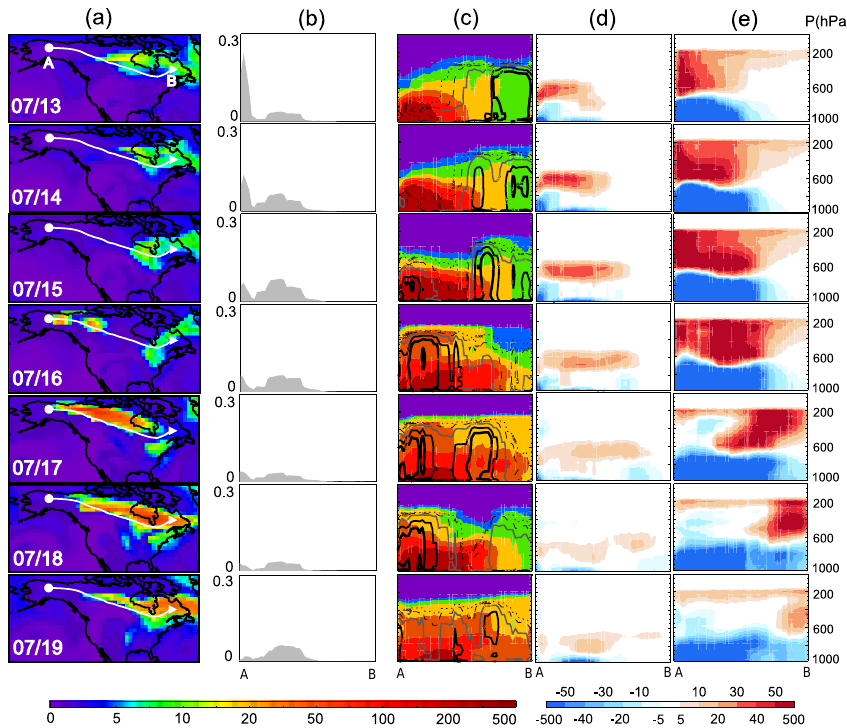
Fig. 14. Simulated daily mean CObbNA (CO from North American biomass burning source) during 13–19 July 2004. (a) CobbNA (ppbv) at 300hPa from the synoptic simulation. White line A–B is derived from the back trajectory analysis using the HYSPLIT model. The starting point B [55 ◦ N, 67 ◦ W] is located at 5km above the ground level and the back trajectory starting time is 00:00UTC, 19 July . (b) Total biomass burning emission rate (TgC/month) in grid cells along the trajectory A–B. (c) CObbNA vertical profile along the trajectory A–B from the synoptic simulation. Line contours represent the deep convection mass flux (kg/m 2 /s) from the GEOS-4 reanalysis database. The contour levels are 0.005, 0.01, 0.02, 0.04, 0.06, 0.1 from light dashed line to thick solid line. (d) CObbNA difference along the trajectory A–B between the MISRind and synoptic simulations. (e) CObbNA difference along the trajectory A–B between the uniform and synoptic